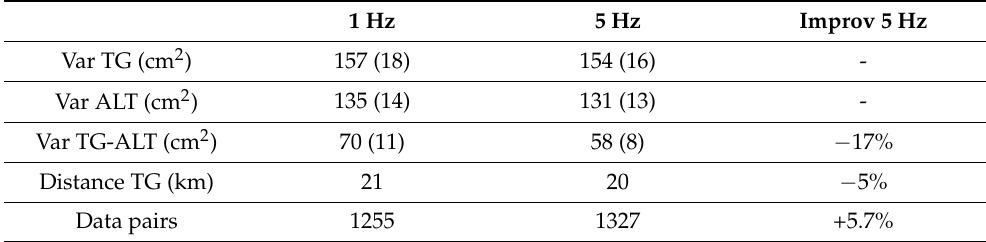
Table 7. Same as Table 6 but using J3